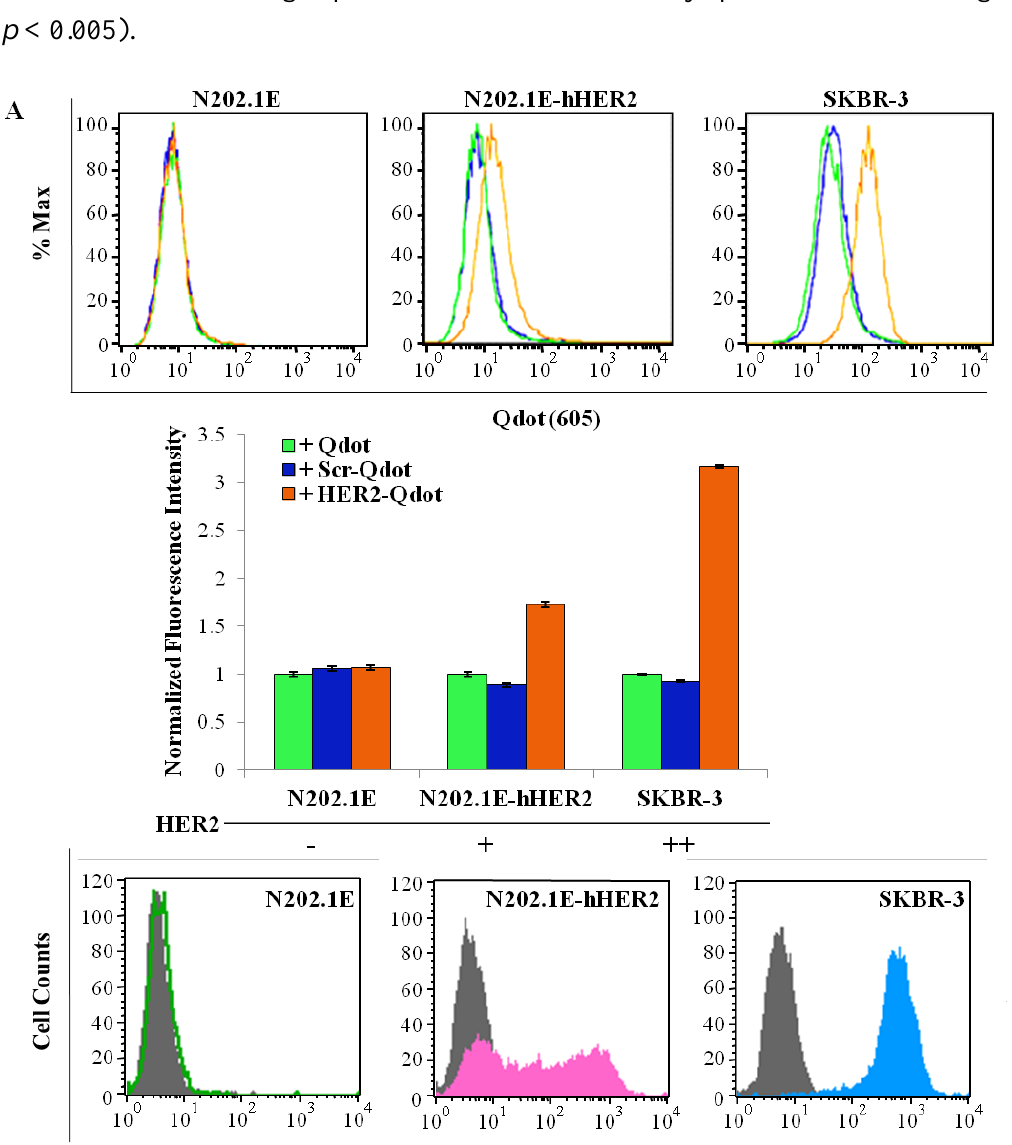
Figure 4. Evaluation of aptamer binding and internalization by flow cytometry. ( A ) Cell- specific binding of a human HER2 aptamer-Qdot conjugate. Cell lines expressing HER2 receptor (N202.1E-hHER2 and SKBR3) and HER2 non-expressing cell line (N202.1E) were incubated for 45min at 37  C with human HER2 aptamer conjugated to Qdots (605nm). Cell-specific aptamer binding was evaluated by flow cytometry (upper panel). Quantification of specific fluorescence signal is shown in the middle panel bar graph. Cell surface human HER2 receptor expression in N202.1E, N202.1E(hHER2) and SKBR-3 cells (grey for isotype control, colored histograms for anti-HER2 Ab) (lower panel). ( B ) Measurement of A9g cell-internalization. PSMA-positive cells were incubated with FAM- A9g aptamer for 30 min at either 4  C (left top panel) or 37  C (right top panel). Cells were then washed with either DPBS or a High Salt (DPBS plus 0.5M NaCl) wash for 5min at 4  C. The high salt wash step removes any unbound or surface bound aptamer. Bound and/or internalized aptamers were subsequently visualized using flow cytometry. *, internalized aptamer fraction (middle right panel). Fluorescence intensity quantified in the bar graph (**, p <